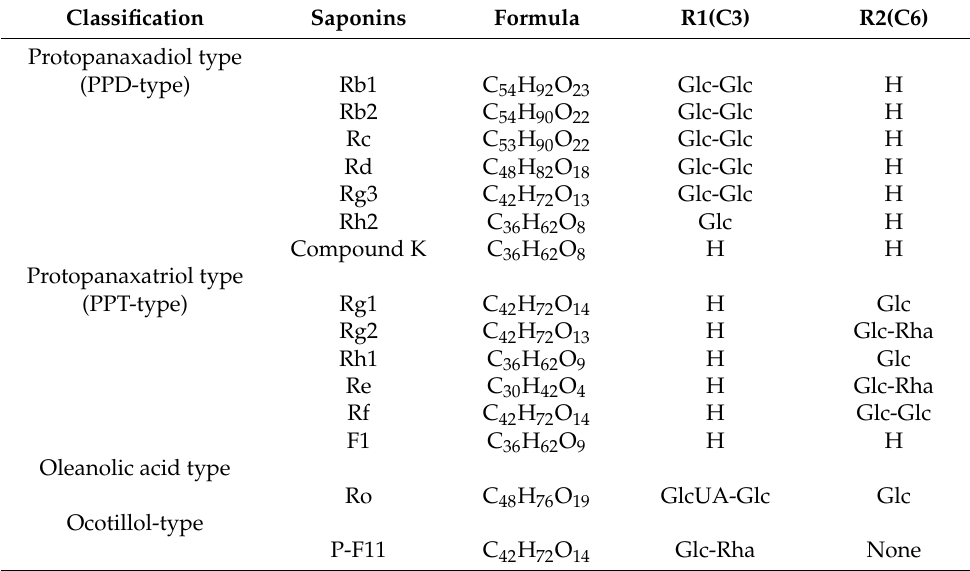
Table 1. Summary of ginseng saponin